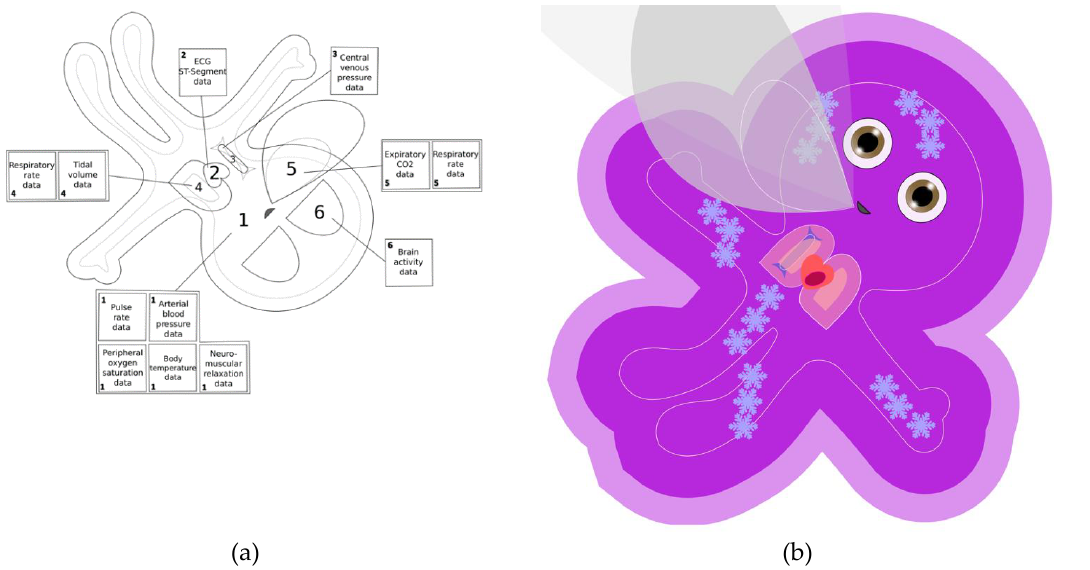
Figure 1. (a) Schematic description of the avatar. The avatar is displayed with its head toward the bottom of the monitor to represent the habitual viewpoint of an anesthesia provider during anesthesia. The numbers 1 through 6 describe the elements of the avatar: 1 = body, 2 = heart, 3 = vena cava, 4 = lungs, 5 = expiratory carbon dioxide cloud, and 6 = eyes. (b) A Visual Patient avatar oriented in an upward direction. This view could be used in an intensive care unit, where the practitioners usually stand at the opposite side of the patient bed.